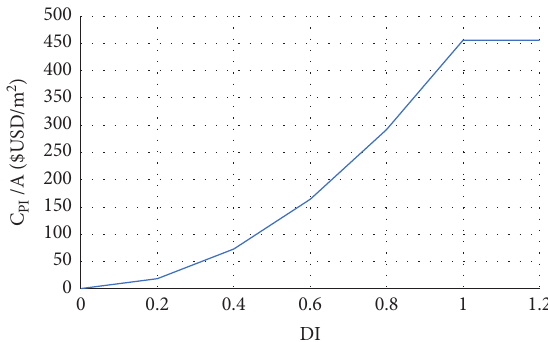
Figure 4: Economic loss as function of the damage index.